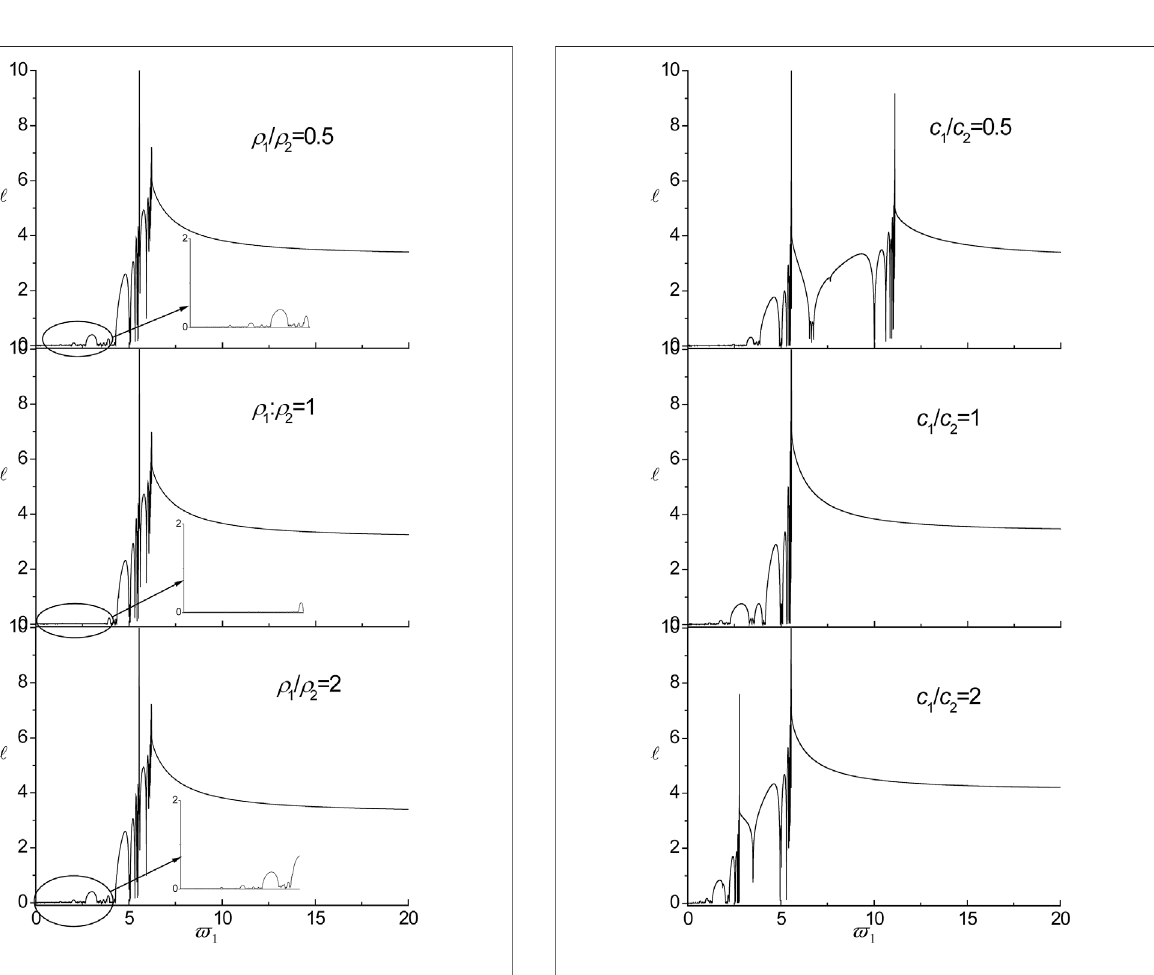
FIGURE8| Thein fl uencesofratioofmassdensityonlacalizationfactors in the nanoscale Fibonacci systems consisting of Cu/Al for τ 1 = τ 2 = 0.18.